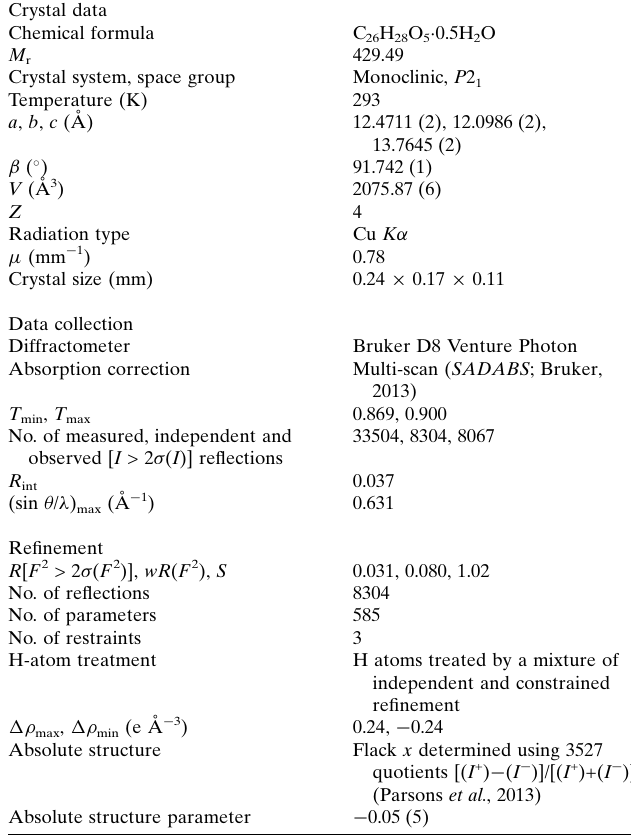
Table 1 Hydrogen-bond geometry (A˚ , (cid:3) ). Cg 1 and Cg 2 are the centroids of the furan rings O5/C19–C22 and O5 B /C19 B – C22 B , respectively.